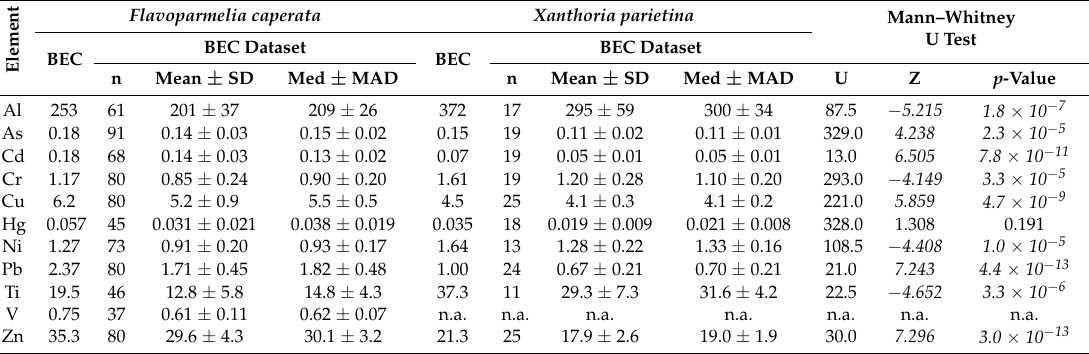
Table 3. Review-based BECs ( µ g g − 1 DW) for the epiphytic lichen species Flavoparmelia caperata and Xanthoria parietina in Italy. Descriptive statistics refer to the data counts (n), mean and associated standard deviation (Mean ± SD), and median and median absolute deviation (Med ± MAD) for 11 ( F. caperata ) and 10 elements ( X. parietina ) included in the BEC dataset (Section 2.2). Results of statistical testing (Mann–Whitney U test for independent samples) for differences between median element concentration in the two species are also reported. Significant p -values are highlighted in italic (n.a., data not